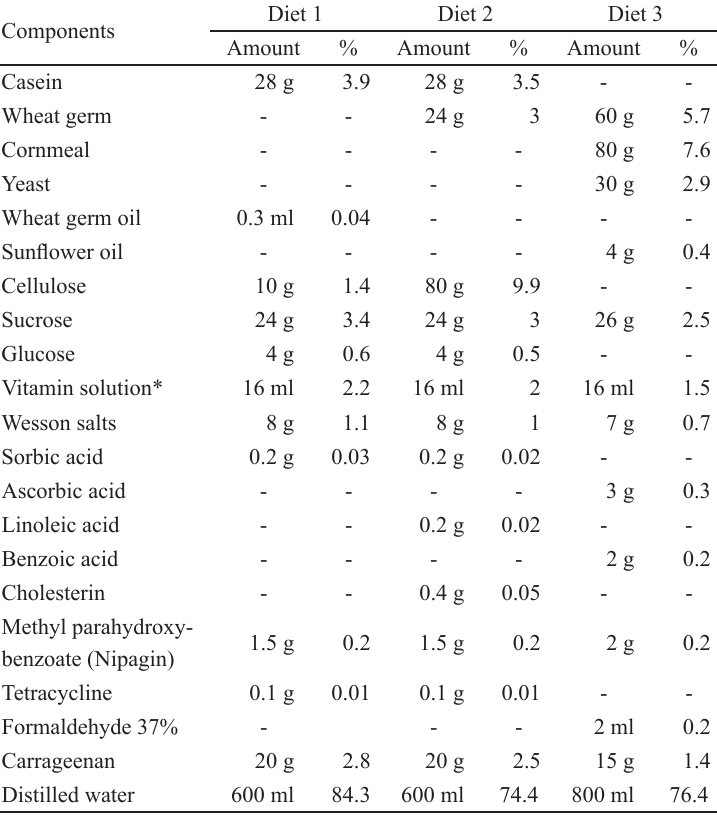
Composition of diets evaluated for the development of Condylorrhiza vestigialis in the